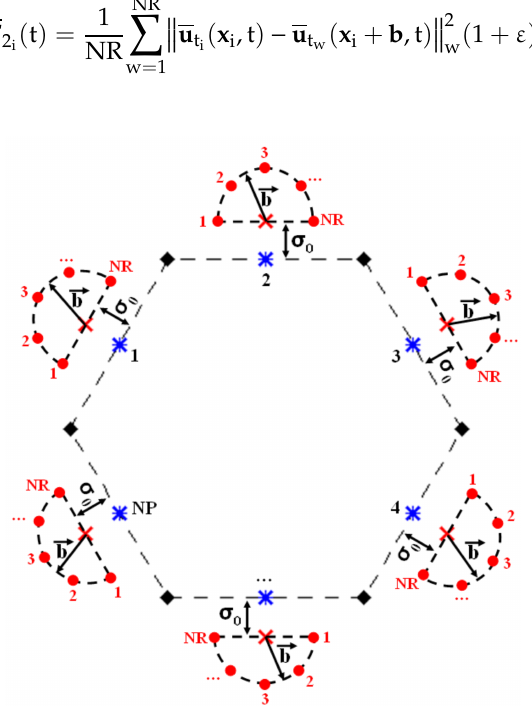
Figure 4. Turbulent activity computation in the vicinity of each shedding